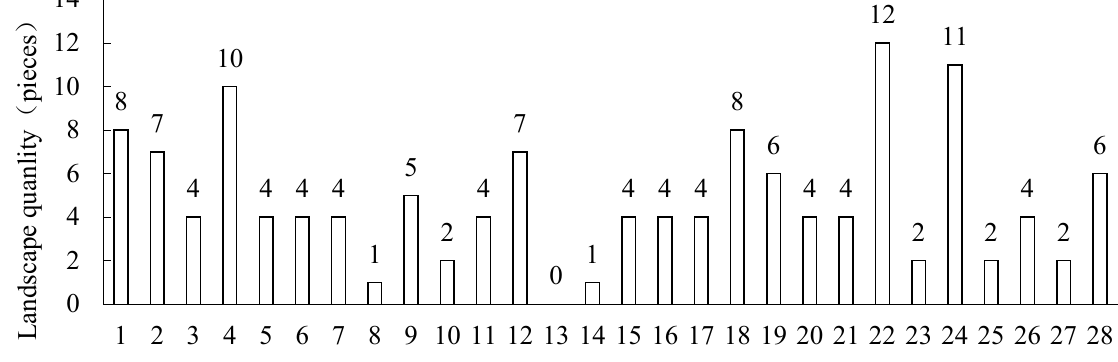
Figure 4. Number of landmark landscapes observed in sample plots. Table 5. Types of landmark landscapes observed in sample plots.